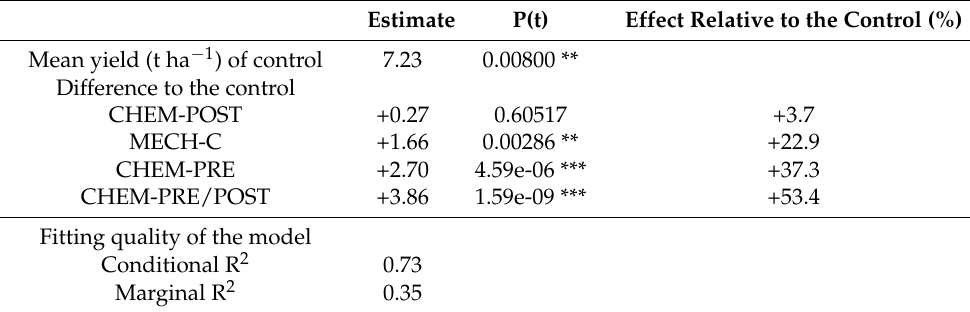
Table 7. Regression: effect of weed control treatments on yield (t ha − 1 ). The proportion of the model’s explained variance and significance (F-test). Marginal R 2 provides the variance explained only by fixed effects and conditional R 2 provides the variance explained by the entire model, i.e., both fixed effects and random effects. Estimate P(t) Effect Relative to the Control (%) Mean yield (t ha − 1 ) of control 7.23 0.00800 ** Difference to the control CHEM-POST +0.27 0.60517 +3.7